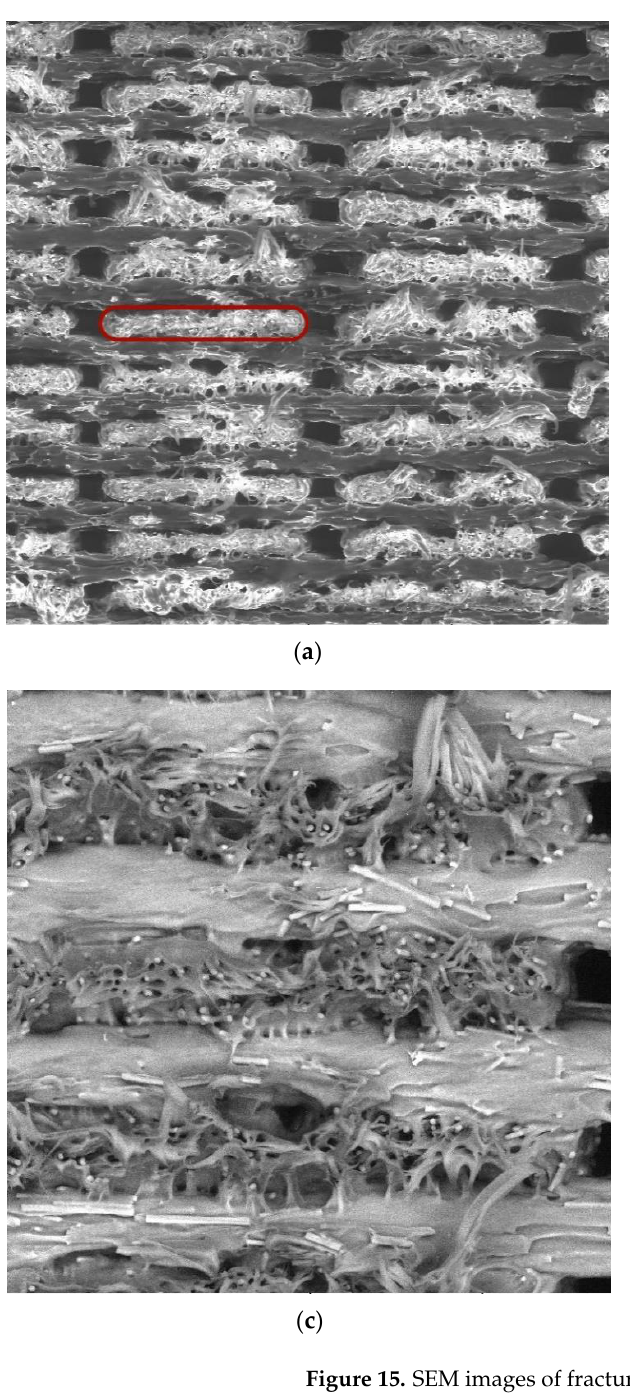
Figure 14 . SEM images of fractured specimen alpha: ( a ) 100× magnification, detector LVSD; ( b ) 300× magnification, detector LVSD; ( c ) 300× magnification, detector BSE; ( d ) 500× magnification, detector BSE.